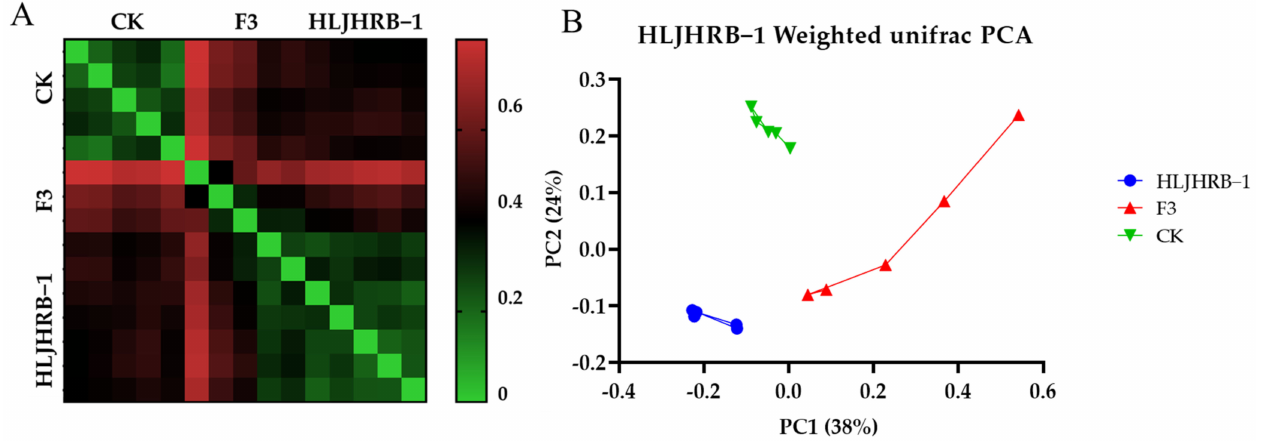
Figure 9. Distance for heatmap ( A ) and PCA ( B ) of HLJHRB-1 and